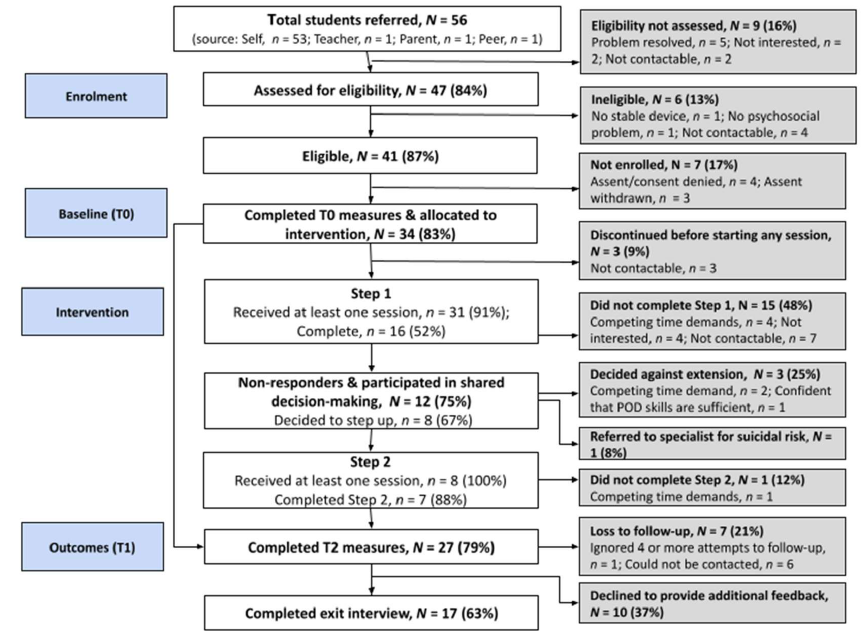
Figure 1. Participants flow in research and intervention activities.